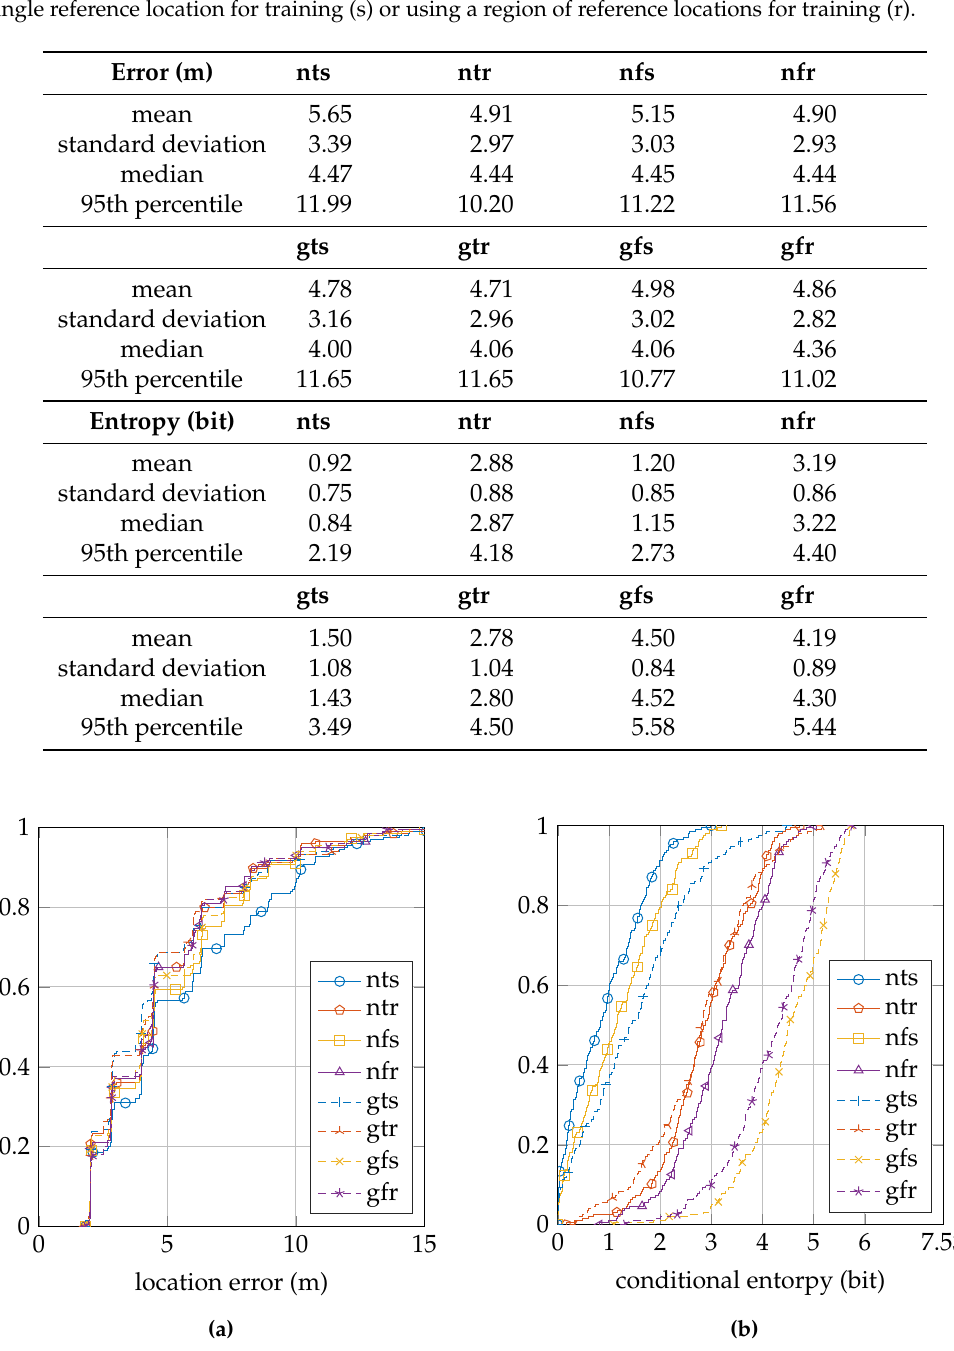
Figure 7. EVARILOS cumulative distributions: ( a ) location error; ( b ) conditional entropy. The legend labels refer to using the normal sensor model (n) or using the convolution sensor model (g), using the trained σ (t) or using the fixed σ (f) and using a single reference location for training (s) or using a region of reference locations for training